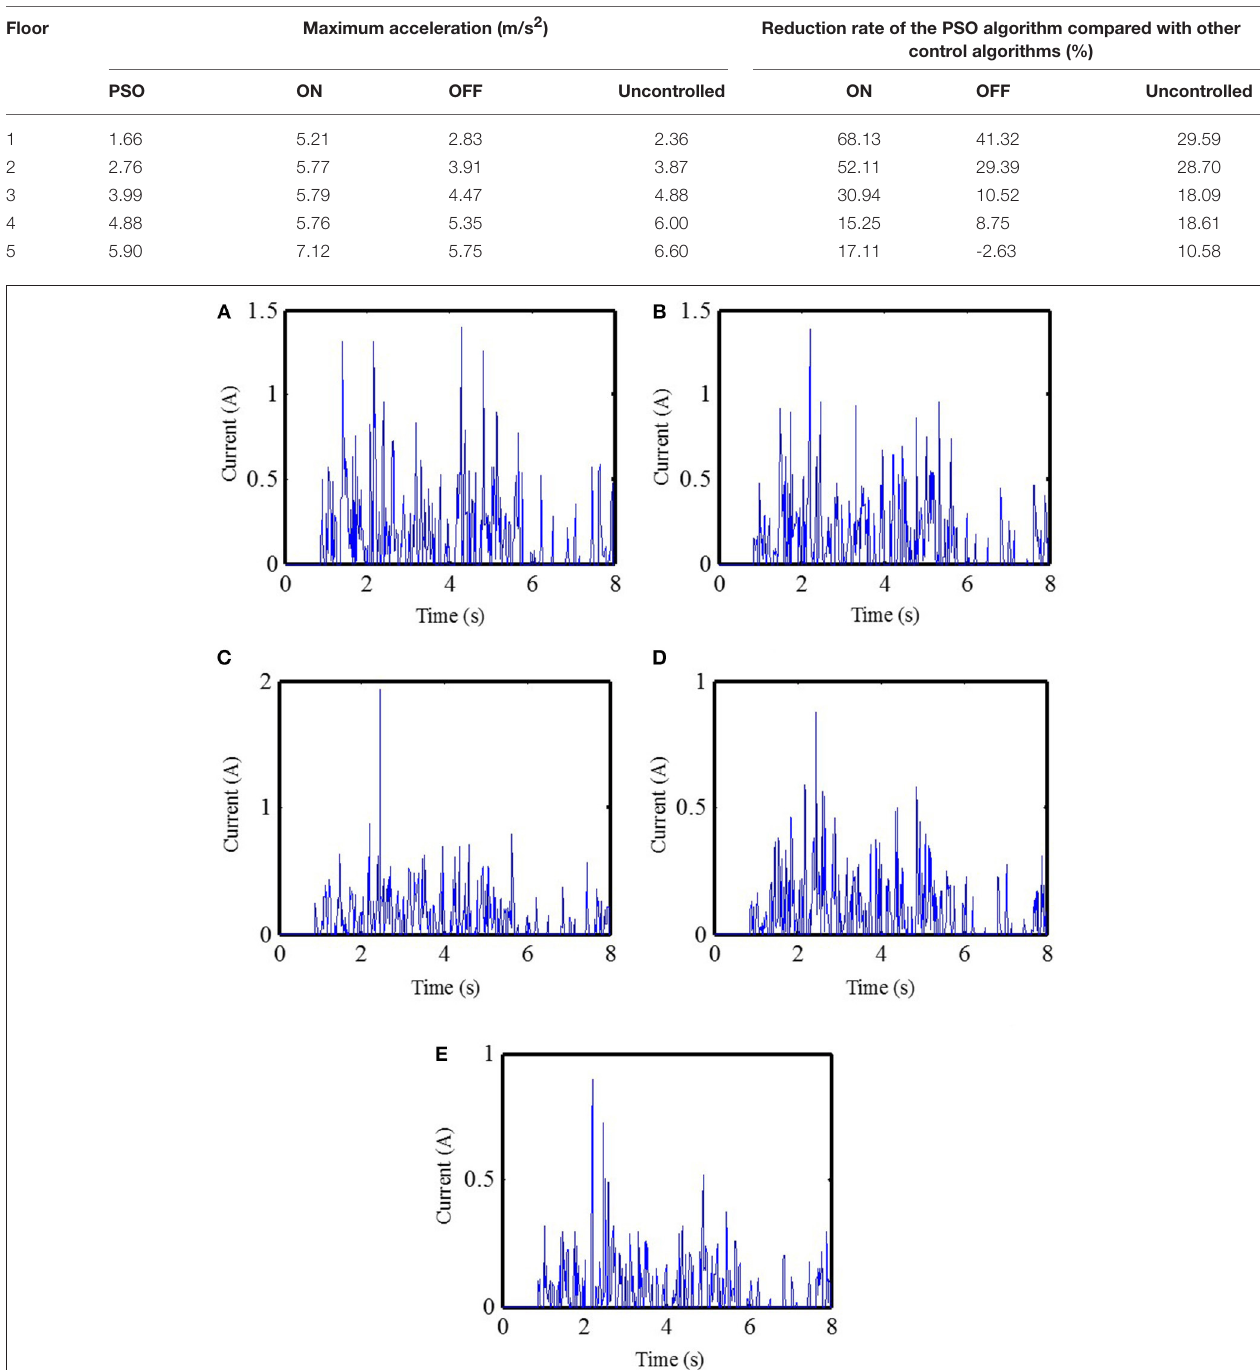
TABLE 2 | The maximum acceleration responses comparison of each floor (El-Centrol). Floor